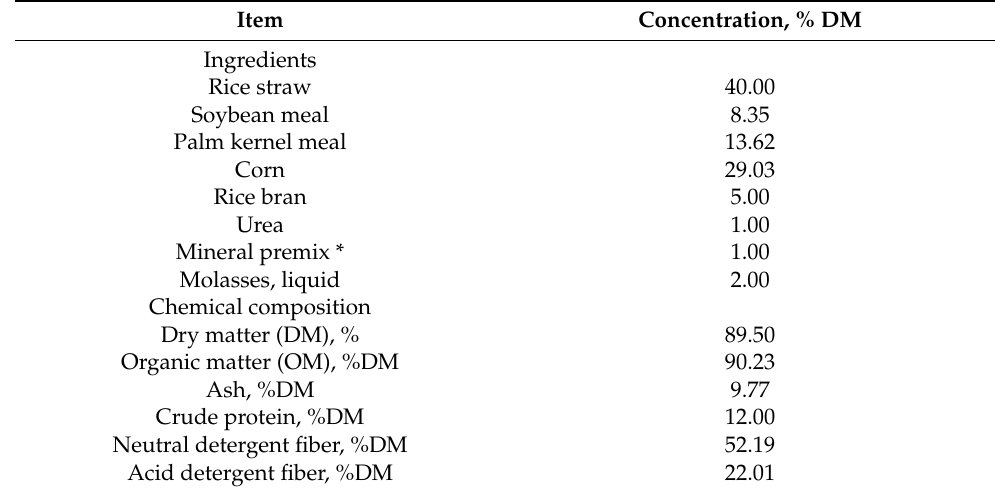
Table 1. Total mixed ration diet and their composition of experiment.